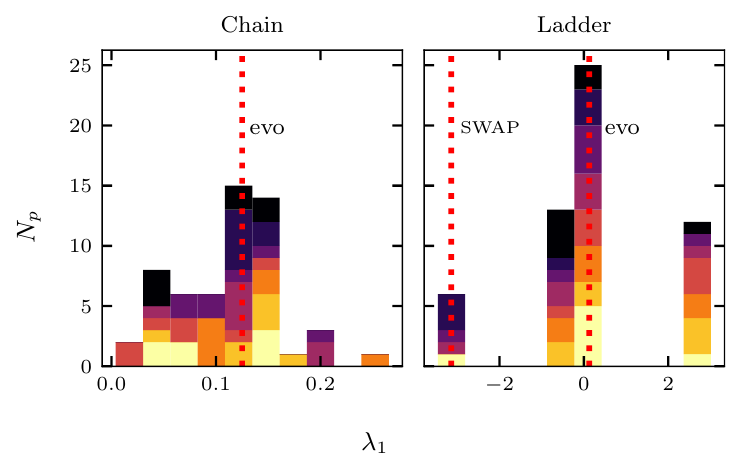
Figure 12: The distribution of the λ parameter which enters the two-qubit unitary 1 parameterization that was used in this work, shown for the chain (left panel) and ladder (right panel) with L = 8 at t = 1. The parameter count N for a compressed p circuit with M = 8 is shown as a stacked histogram, with the lightest color corre- sponding to the bottom layer and the darkest color to the top layer. The first-order = t / M and the SWAP gate value λ SWAP = − π are Trotter evolution gate value λ evo 1 1 shown as dashed red lines. The other two-qubit parameters λ and λ are distributed 2 3 similarly. Note the different scales of the